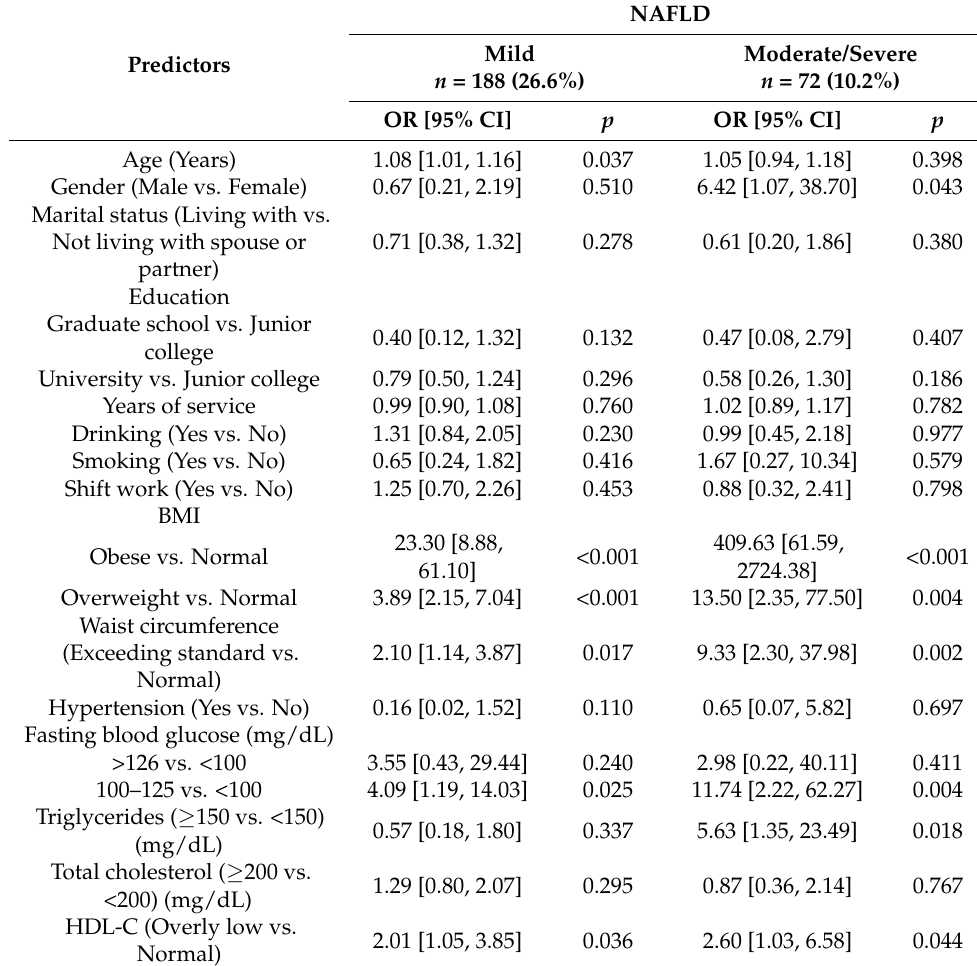
Table 3. Multinomial logistic regression analysis of factors influencing NAFLD severity in nurses.